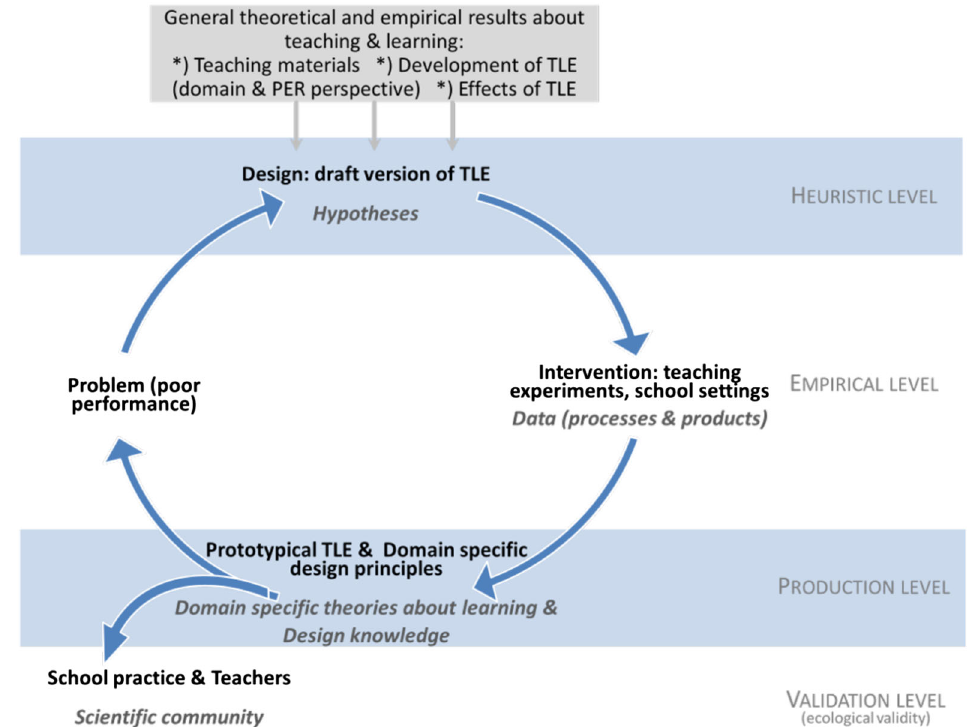
FIG. 3. Model of DBR with superposed development and research space. The successive stages of the development process are written in bold, black letters, related stages of the research process in gray